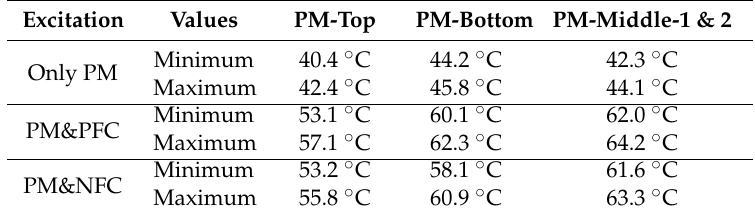
Table 5. Typical temperature values in PMs when ferrite is employed.